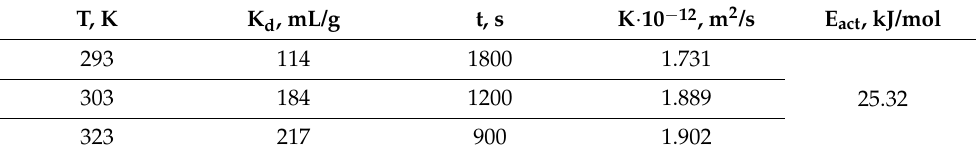
Table 4. Kinetic parameters of niobium sorption with Purolite A-100 anion-exchange resin. T, K K d , mL/g t, s K · 10 − 12 , m 2 /s E act , kJ/mol 293 114 1800 1.731